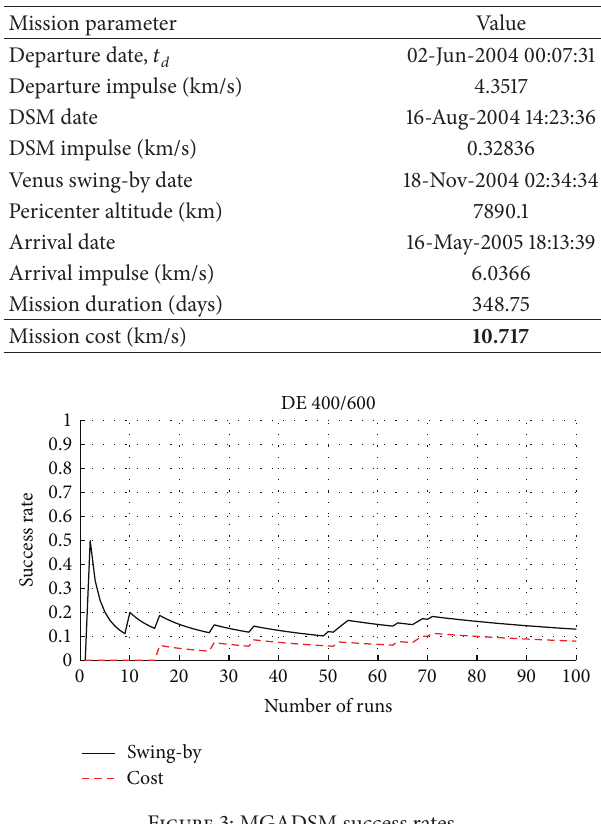
Figure 3: MGADSM success